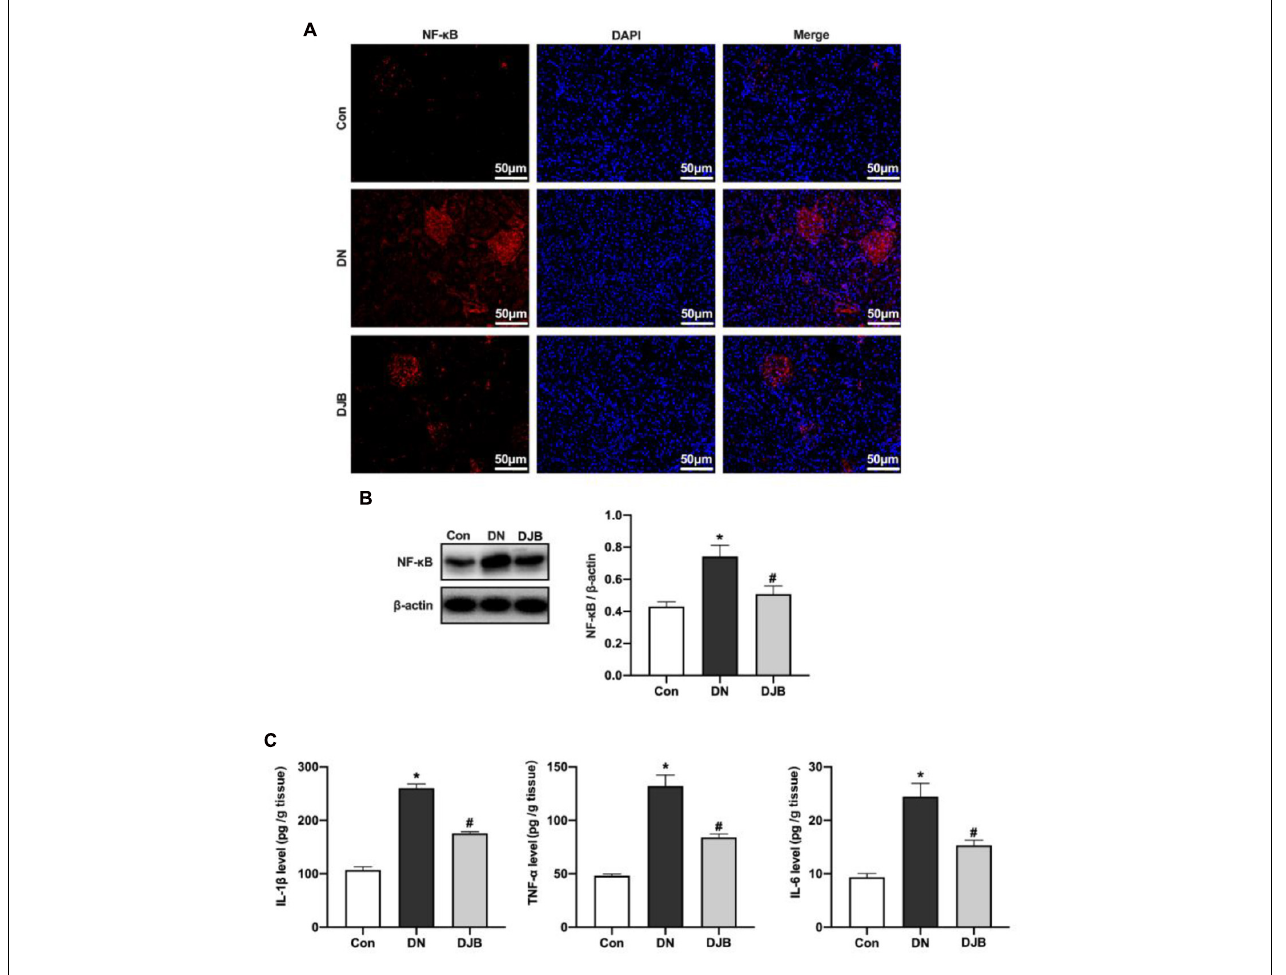
FIGURE 4 | Bariatric surgery reduced the expression of NF- κ B p65 to inhibit inflammation in diabetic rats. The expression of NF- κ B was detected by immunofluorescence (IF; scale bar , 50 µ m) (A) and Western blotting (B) . (C) Levels of the inflammatory factors (TNF- α , IL-1 β and IL-6) in rat renal tissues examined by ELISA. All data represented the mean ± SD. * p < 0.05 [compared with the control (Con) group]; # p < 0.05 [compared with the diabetic nephropathy (DN)